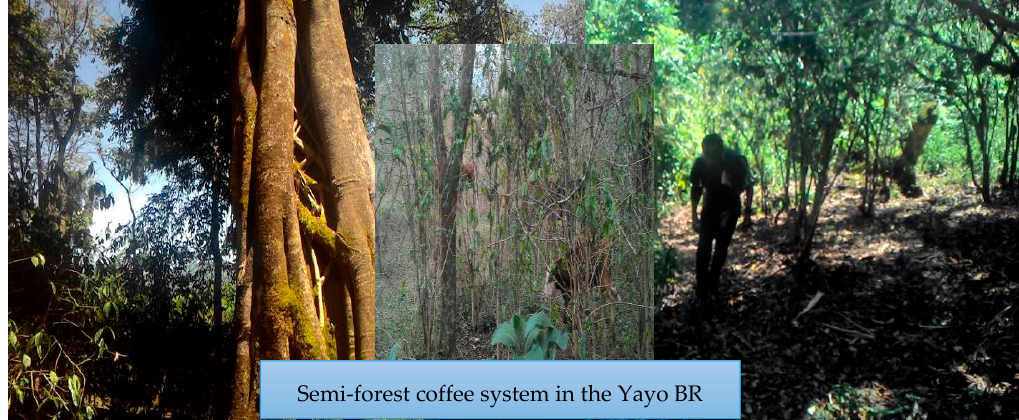
Figure 4. Pictures of semi-forest coffee production systems in the Yayo BR, photo taken by the author, April 2017.